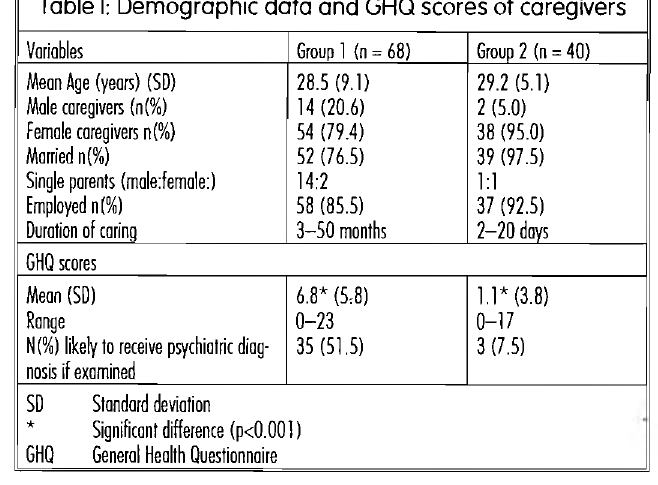
Table 1: Demographic data and GHQ scores of caregivers